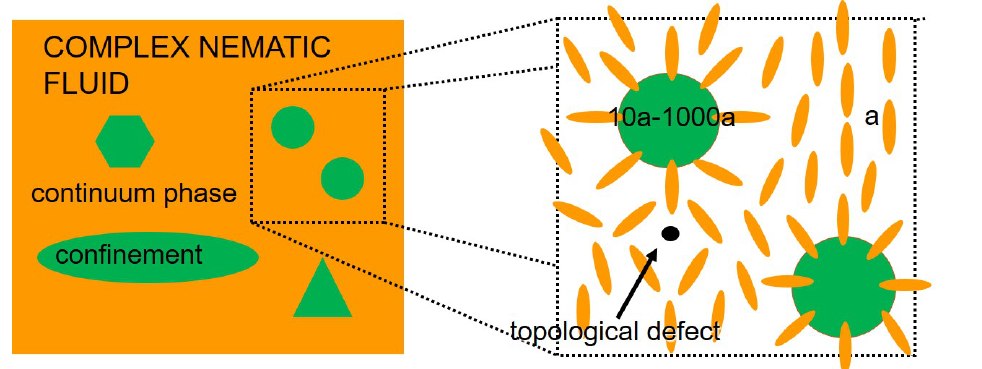
Figure 1. Schematic representation of complex nematic structures. Orange shows continuum liquid crystal phase consisting from nematic building blocks with characteristic size a . Green indicates general confinement which can be imposed either by different surfaces, such as particles and channel or cell walls. A scheme of a topological defect is shown in